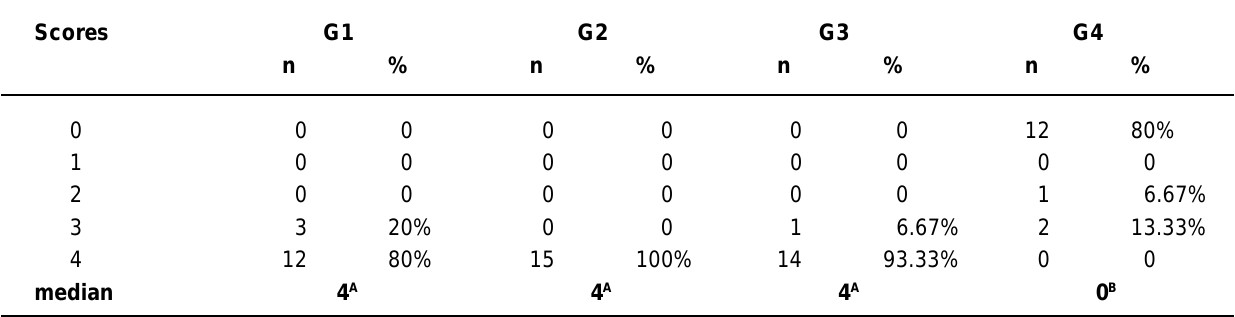
TABLE 3 - Distribution of absolute (n) and relative (%) frequency and median of scores (Vita shade guide) obtained in experimental groups 21 days